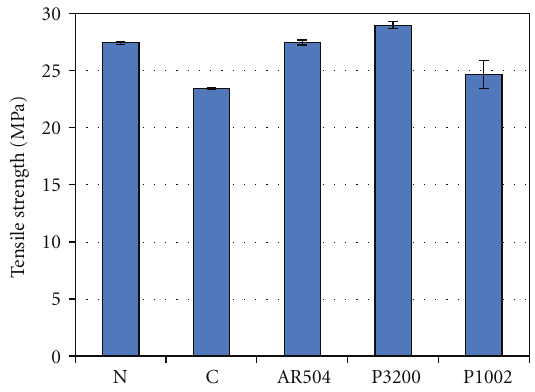
Figure 1: Comparison of tensile strength of neat polypropylene to that of sunflower reinforced polypropylenes with and without the inclusion of chemical compatibilizers. N corresponds to the neat, nonreinforced polypropylene, C to the reinforced control formulation without the addition of a